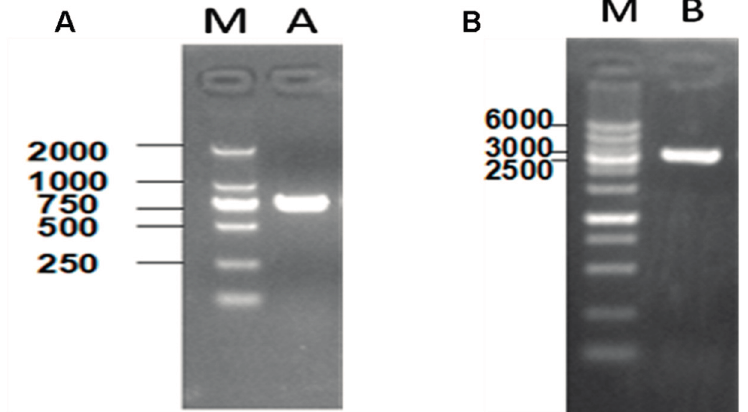
Figure 1. Constructing of recombinant plasmid pET24a (+)-phoN2 and pET32a (+) S-VirG. ( A ) Line A, the phoN2 (741 bp) line. Line M, DL2000 marker; ( B ) Line B, the VirG (3309 bp) line. Line M, DL6000 marker.